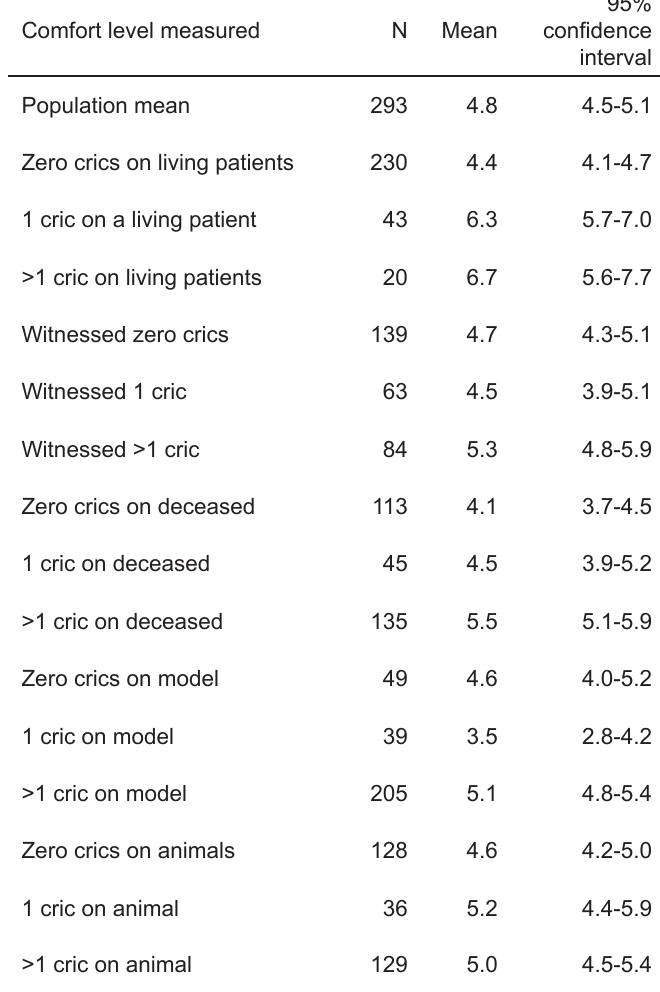
Table 3. Reported comfort level based on number of cricothyrotomies (crics)